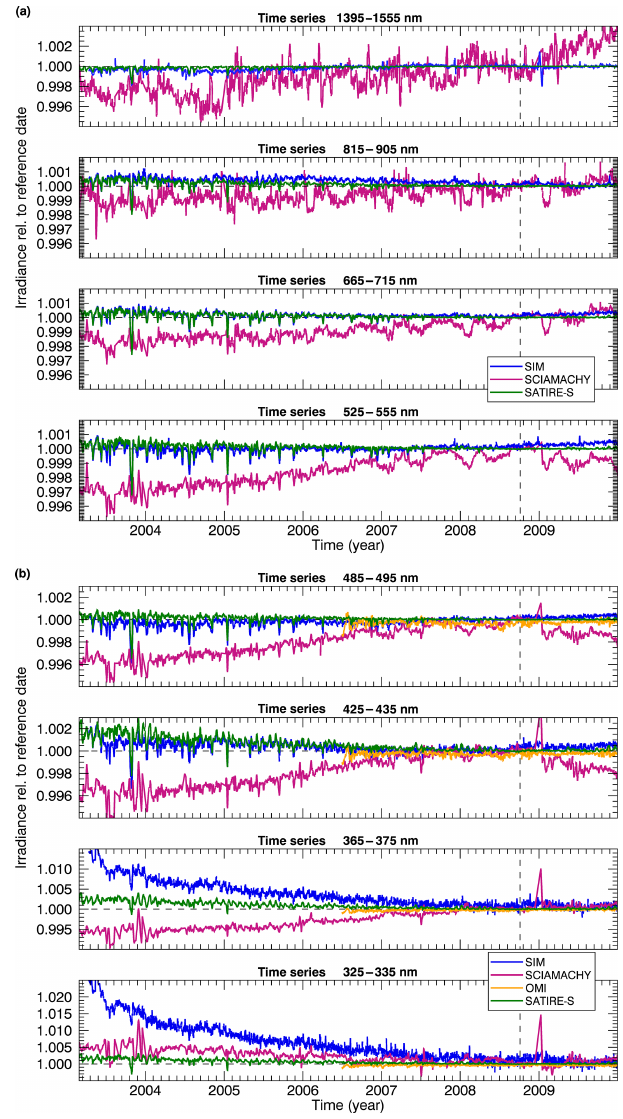
Figure 10. Time series of SSI, integrated into (b) 10nm and (a) 30– 160nm wide wavelength bands from SCIAMACHY, SIM/SORCE V25, OMI/AURA satellite measurements, and SATIRE-S. The time series are ratioed to values from 5 October 2008, which are repre- sentative of solar minimum conditions. For details, see text. (Note the change in vertical scale for the different wavelength